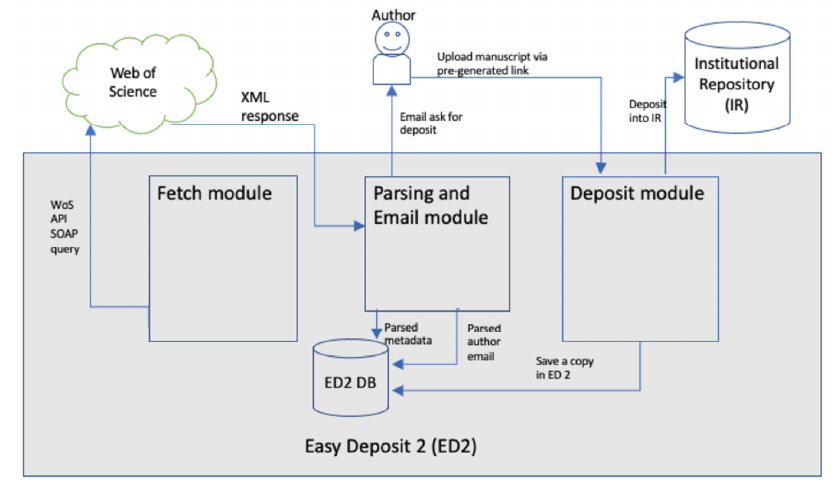
Figure 1. Easy Deposit 2 (ED2) system diagram.